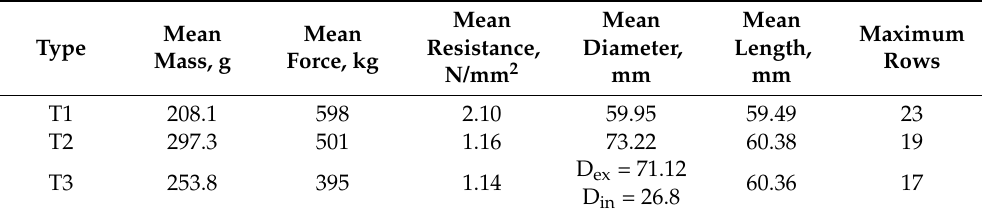
Table 1. Modeling to find the maximum number of existing rows in a stack depending on the com- compression pression resistance.